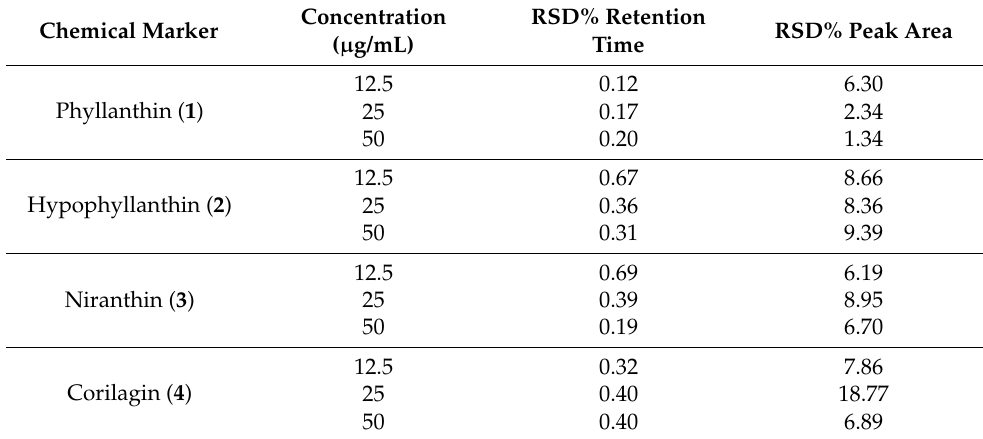
Table 3. Intermediate precision of compounds.